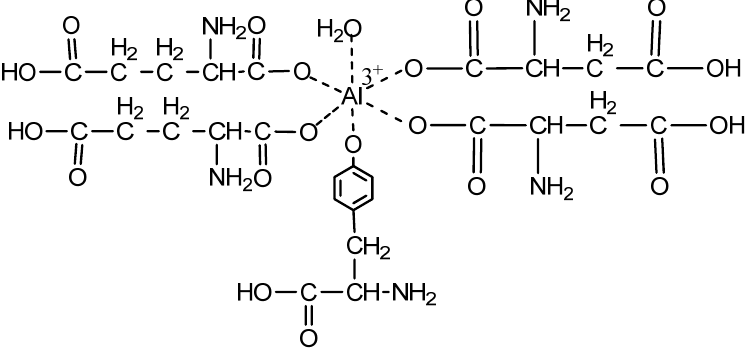
Figure 1. The possible formation of casein–aluminum ion complex, the so called metalloprotein formation.